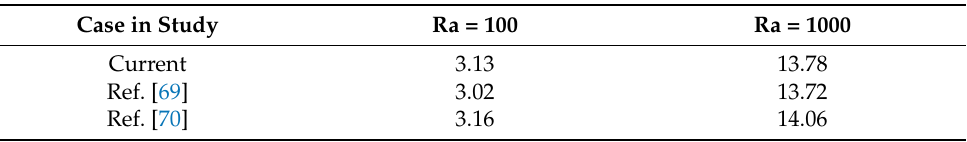
Table 4. Code validation 2: Comparisons of average Nu for convective HT in a porous enclosure which is differentially